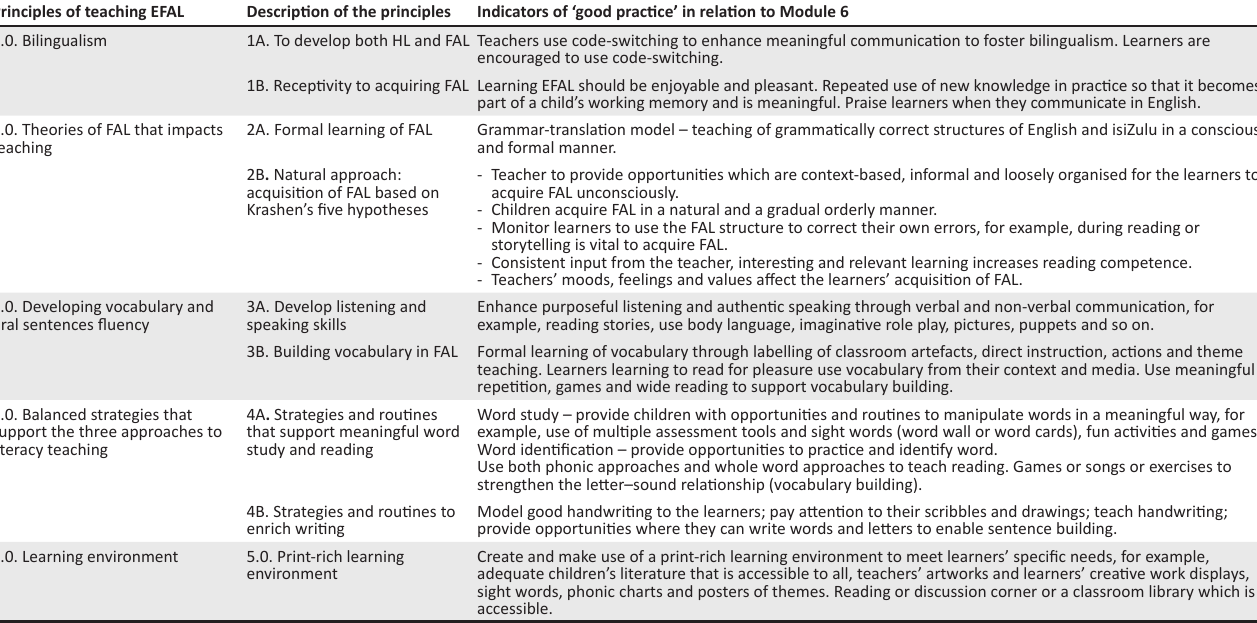
TABLE 1: Principles of teaching English as a First Additional Language advocated in Module 6.